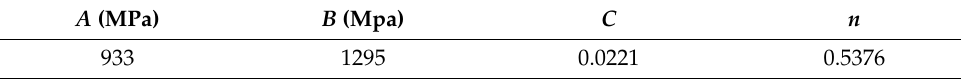
Table 3. Johnson–Cook material model parameters for SBPR 930/1080 Type B No. 1.